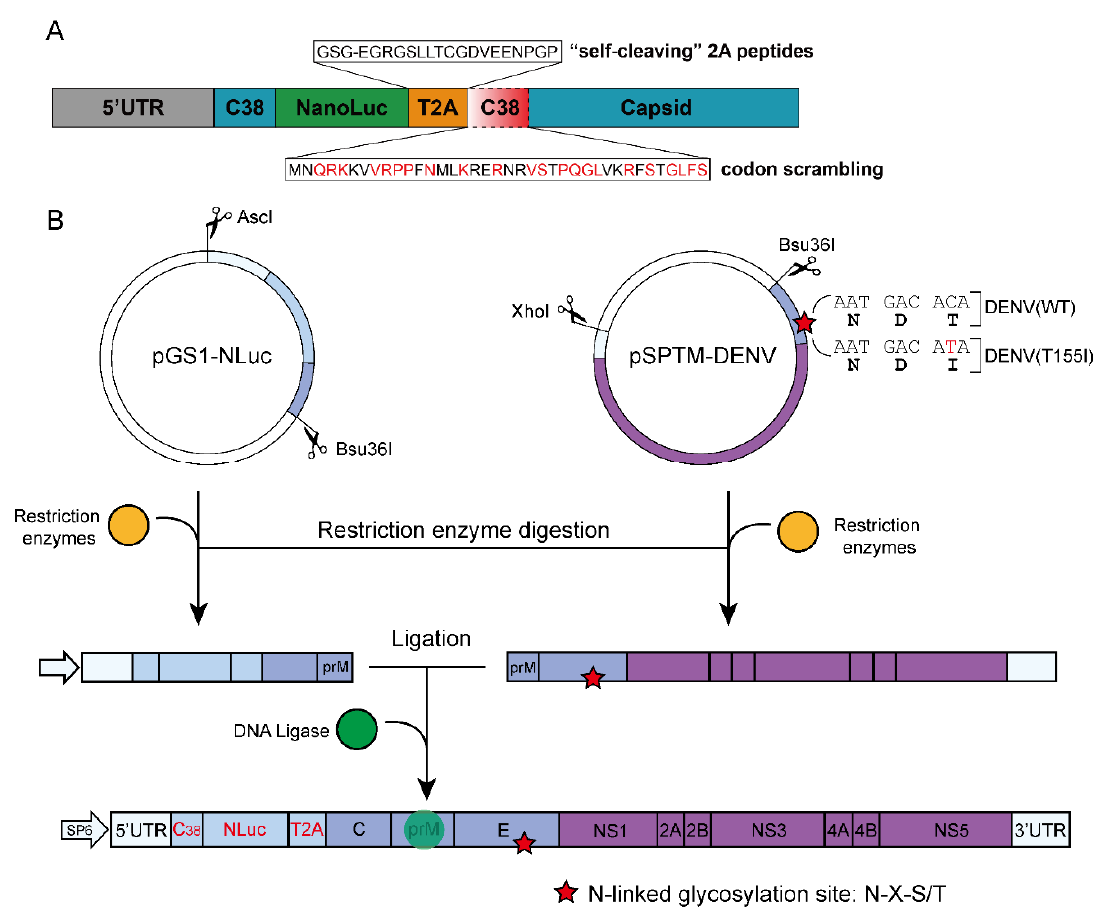
Figure 1. Construction of reporter DENV. ( A ) Construction design of the NanoLuc reporter gene. NanoLuc was linked to the capsid gene by the T2A sequence and was flanked by duplicate sequences of the capsid gene. ( B ) In vitro ligation of full-length cDNA of reporter DENV. Two reporter viruses were constructed, one based on WT DENV, and the other based on a glycosylation site-defective mutation in the E protein.